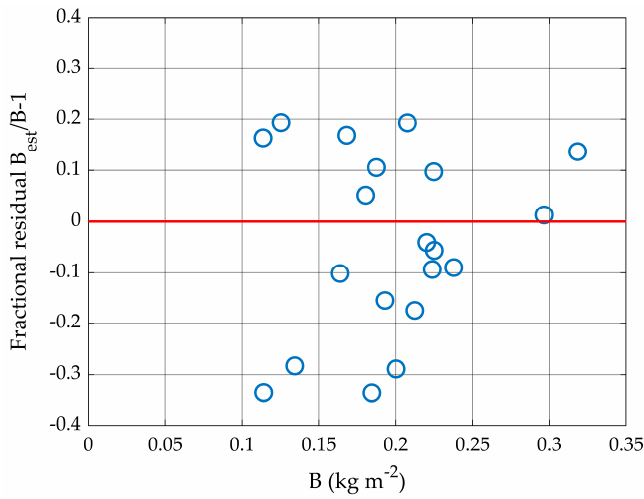
+ c 0 H 1 R 1 , for Pass 6 from Transect 3.